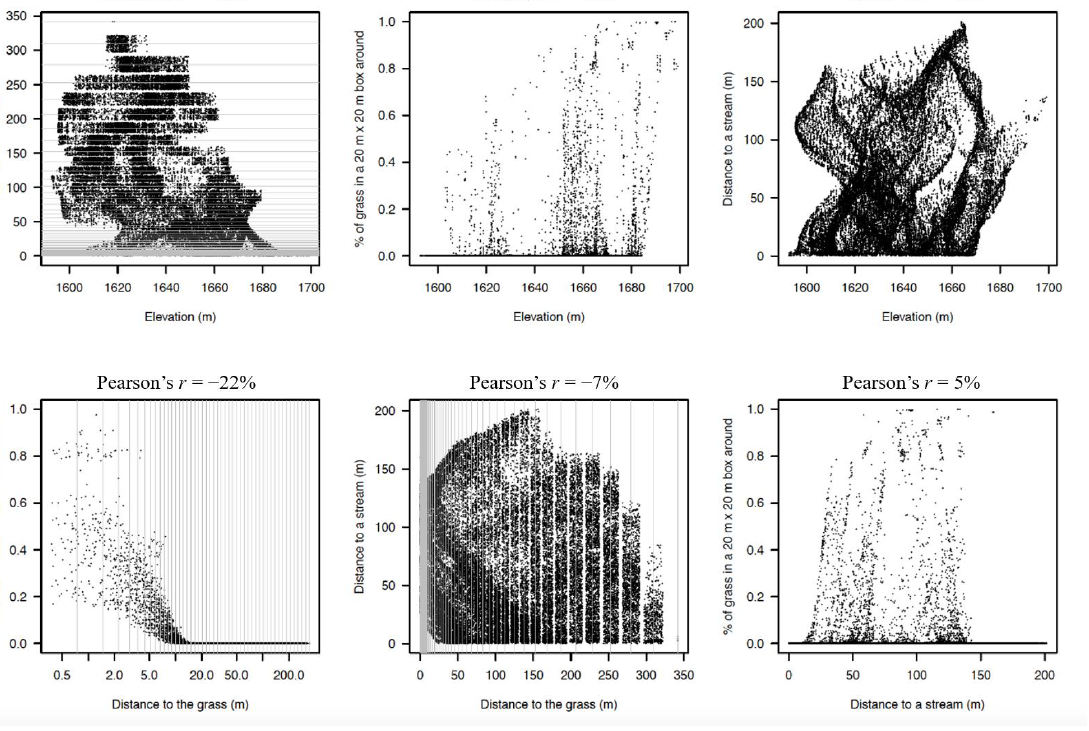
Figure 4. Distribution of individual trees along the four environmental gradients in the Ngel Nyaki plot. Individual trees occur across all gradients, therefore our analysis reflects the underlying correlation between individuals and measured local environmental variables. For computational reasons, the distance to the grass was measured with high resolution at short distances and coarser resolution at larger distances (the maximum peripheral error was constrained to < 15%). The possible values for the distance to the grass are represented by thin grey lines in the figures; the points have been jittered around those possible values for visualization